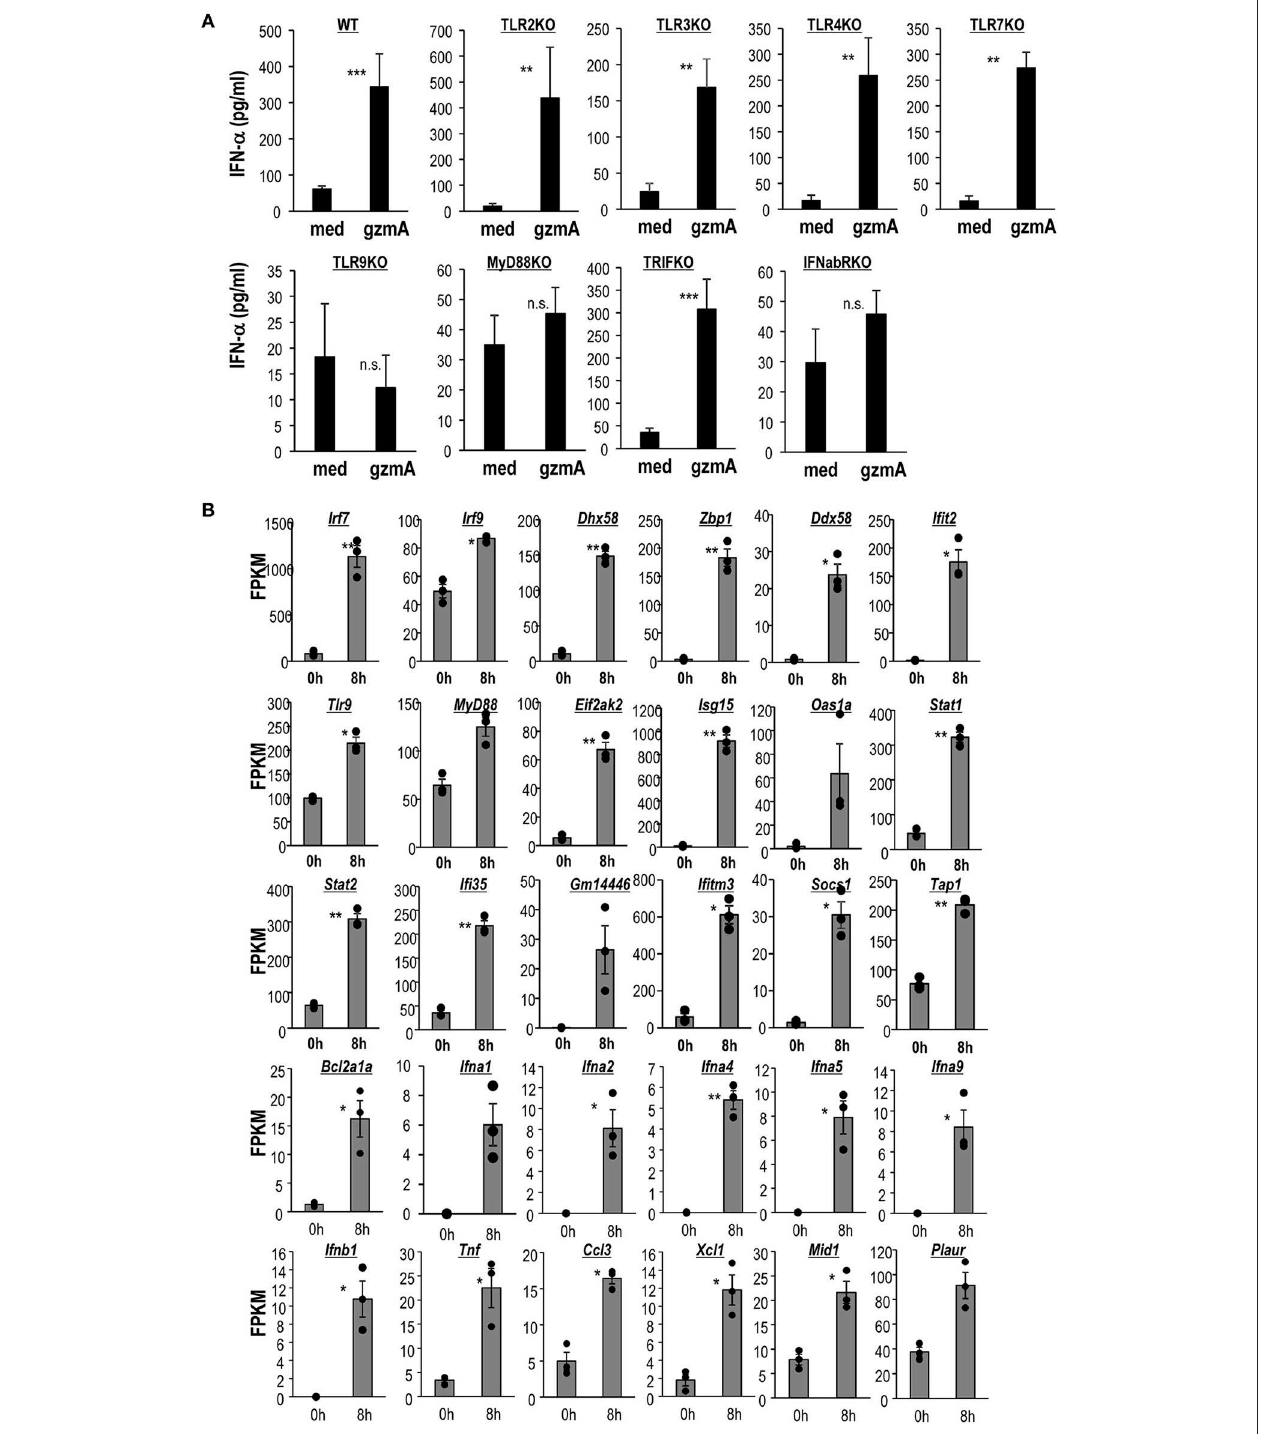
FIGURE 3 | Activation of the TLR9-MyD88 signaling pathway and a distinct transcriptomic signature of GzmA-stimulated pDCs. (A) IFN- α production by FL-DCs from WT or several types of KO mice stimulated with GzmA. FL-DCs were cultured in the presence of GzmA for 24h and the supernatants were measured by ELISA for IFN- α (mean ± SEM, n = 4) medium vs. GzmA, ** p < 0.01, *** p < 0.001 (Mann-Whitney). (B) Analysis of differential gene expression in pDCs before and after stimulation with GzmA. pDCs unstimulated or stimulated with GzmA for 8h were sorted. Differential genes associated with IRF signaling, TLR signaling, IFN signaling, MyD88 signaling, and interferon-responsive genes in pDCs were assessed by RNA-Seq. The gene expression analysis was performed using an R based package, EdgeR with the raw counts from RNA-seq data. Then, expression levels (expressed as FPKM) from selected genes of pDCs under these two conditions were compared ( n = 3, mean ± SEM). * p < 0.05, ** p < 0.01 (paired Student’s t -test).